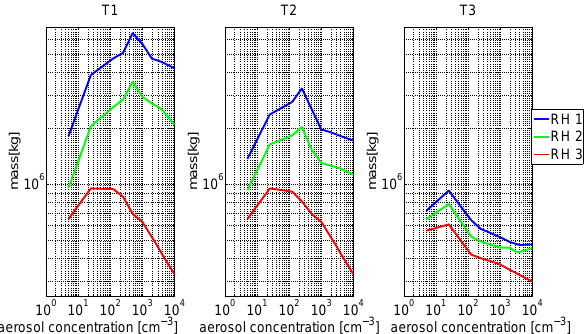
Figure 2. The maximum cloud total mass for each simulated cloud as a function of the aerosol concentration used in the simulation. Each curve represents 10 simulations conducted using the same at- mospheric profile (a total of nine different initialization profiles). T1 represents a profile with an inversion layer located at 4km, T2 at 3km, and T3 at 2km. RH1 represents a profile with 95% RH in the cloudy layer, RH2 90%, and RH3 80%.